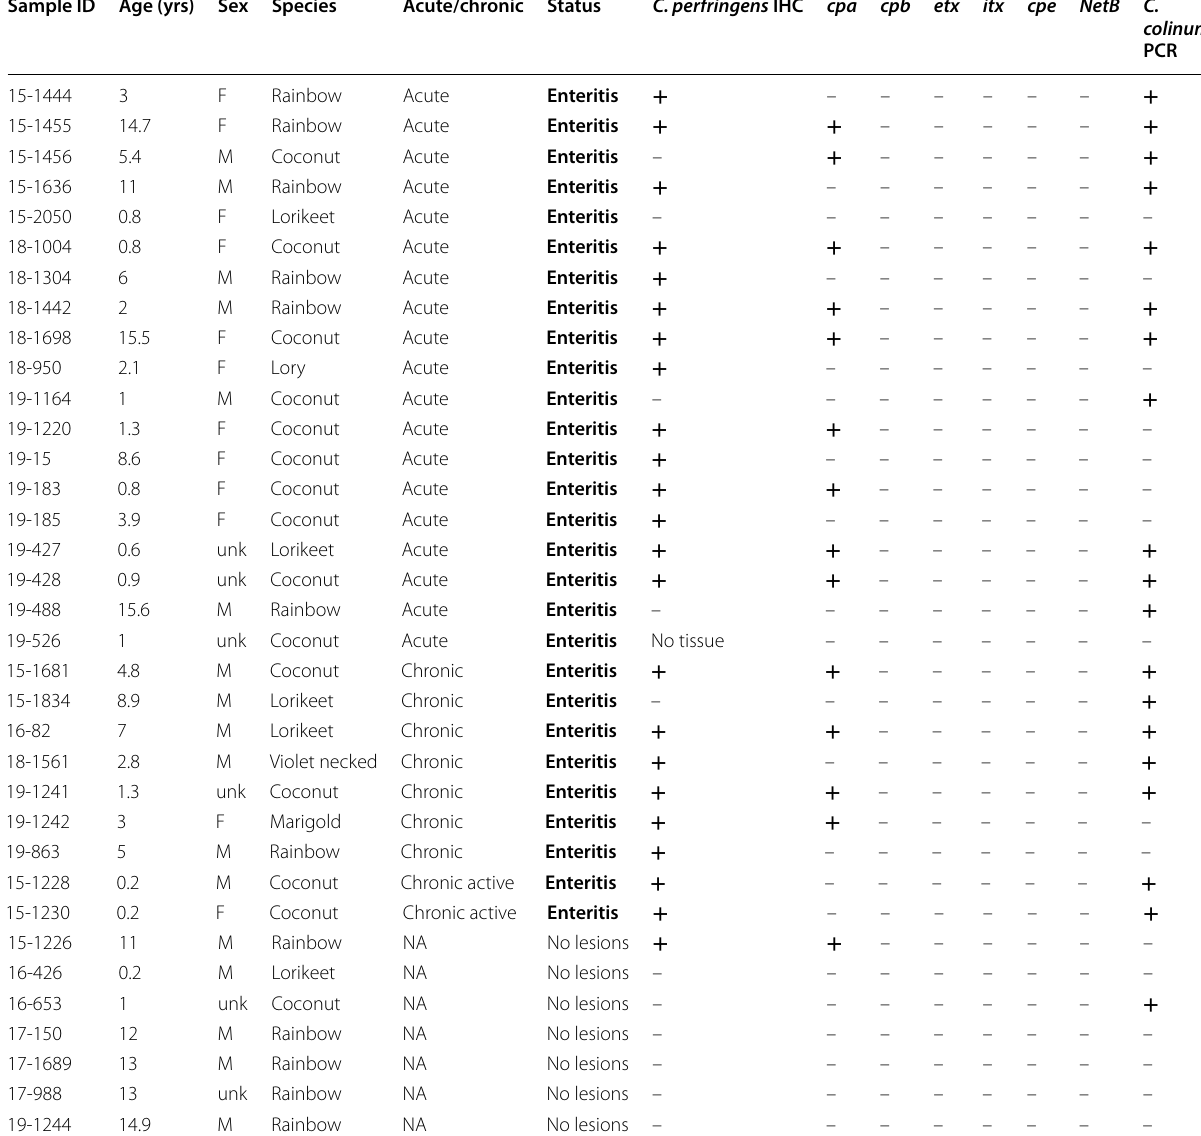
Table 4 Toxin profiles, IHC, and C. colinum PCR on lorikeet intestines submitted to pathology Sample ID Age (yrs) Sex